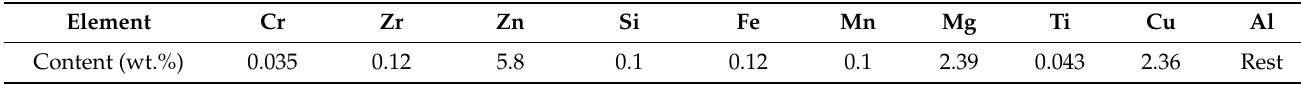
Table 1. Chemical composition of 7050 aluminum alloy.